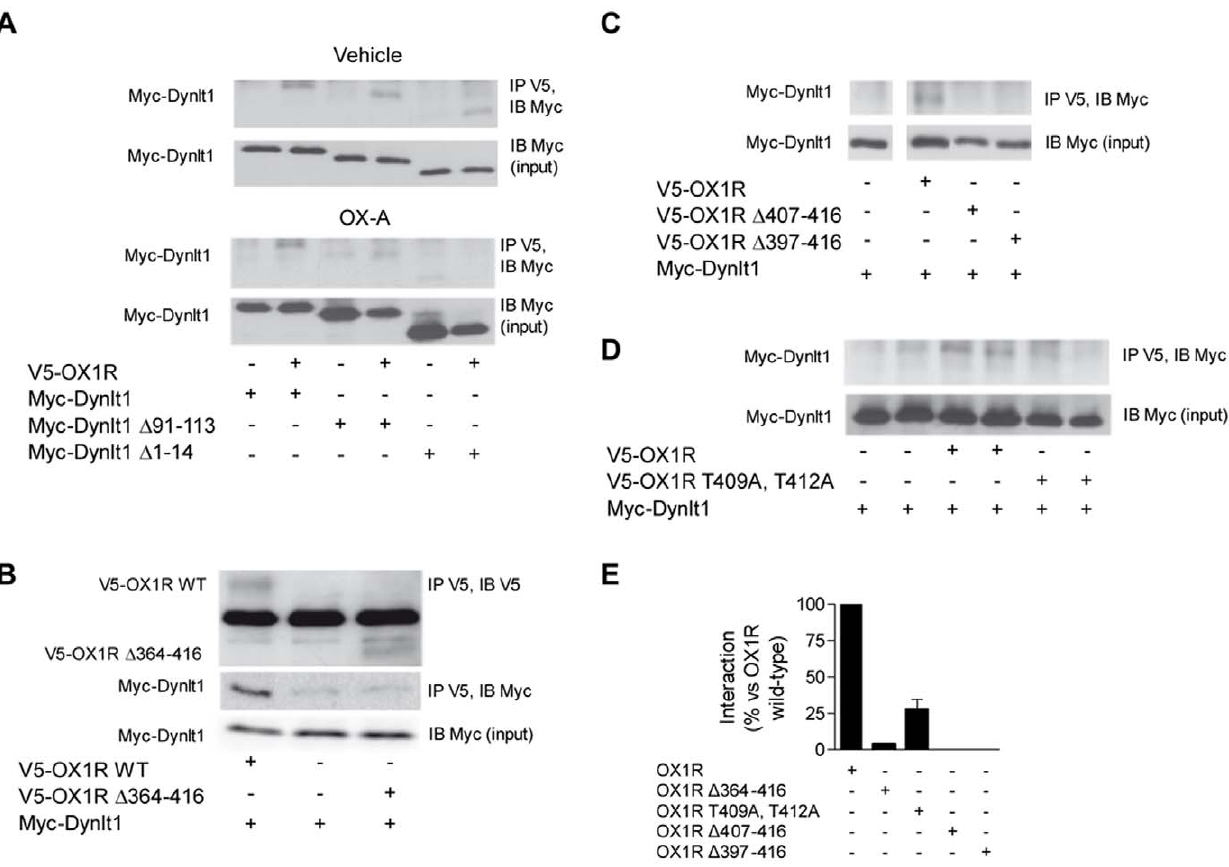
Figure 5. The effect of Dynlt1 mutations and OX1R mutations on their interaction in mammalian cells. ( A ) HEK293 cells were transfected with the indicated constructs and stimulated with orexin-A (OX-A) or vehicle (water) for 30 min. Whole-cell lysates were then subjected to IP as described in Fig. 2. OX1R interaction with Dynlt1 is not disrupted by the presence of deletion mutants of Dynlt1 after addition of vehicle, but it is reduced (compared to wild-type Dynlt1) after stimulation with OX-A. ( B ) HEK293 cells were transfected with the indicated constructs and whole-cell lysates were subjected to IP. Removing the CTD of OX1R abolishes the interaction of OX1R with Dynlt1. ( C, D ) Co-IP experiment performed on whole- cell lysates obtained from HEK293 cell transfected with the indicated constructs (Myc-Dynlt1 and V5-OX1R deletion mutants). Removing the last 10 amino acids from OX1R abolishes its interaction with Dynlt1, while mutating two threonine residues for alanine in the putative Dynlt1-binding motif (Fig. 4A) blunts the amount of Myc-Dynlt1 co-immunoprecipitated with V5-OX1R. ( E ) Quantification of Western blotting bands obtained in panels B, C and D. All transfection conditions and co-IP experiments were performed at least twice.